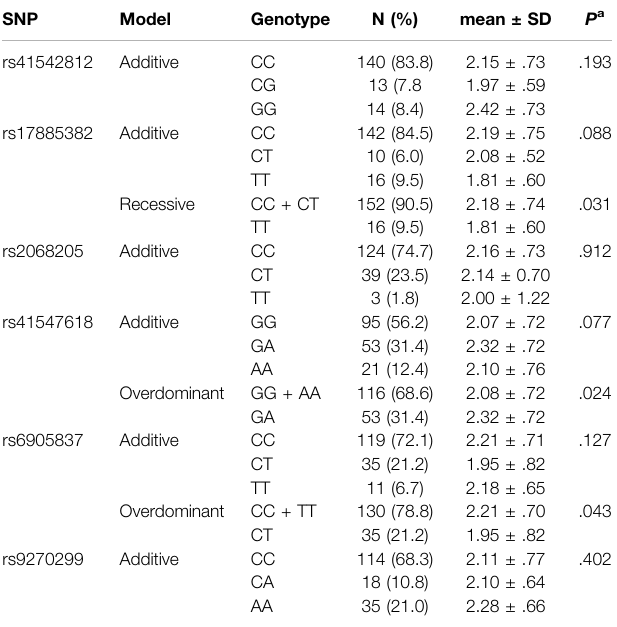
TABLE 6 | Results of covariance analysis for B/Yamagata antibody titers.